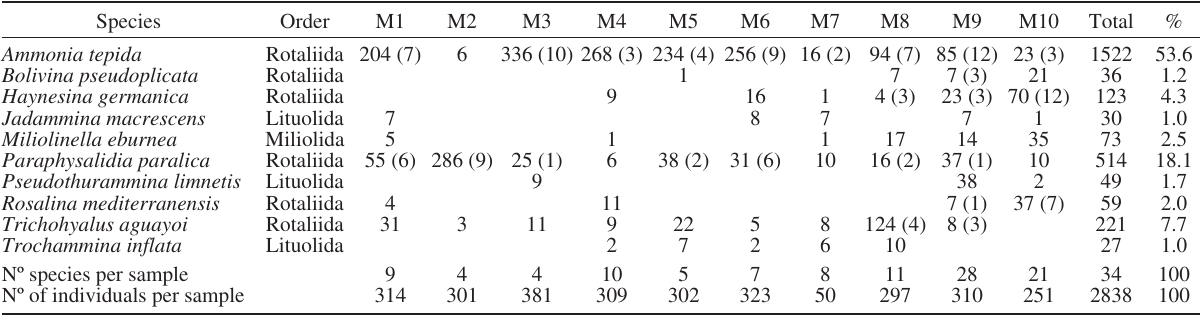
Table 2. – Number of individuals and species of benthic foraminifera >1%. Stained foraminiferal tests are indicated between brackets.